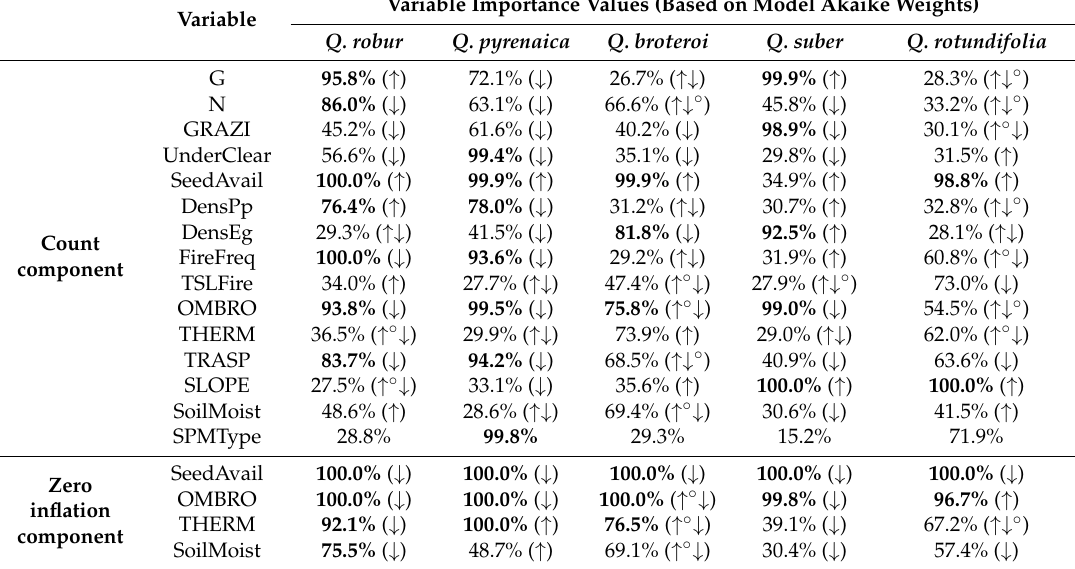
Table 6. Variable importance values based on Akaike weights both for the count and zero inflation components and respective signal